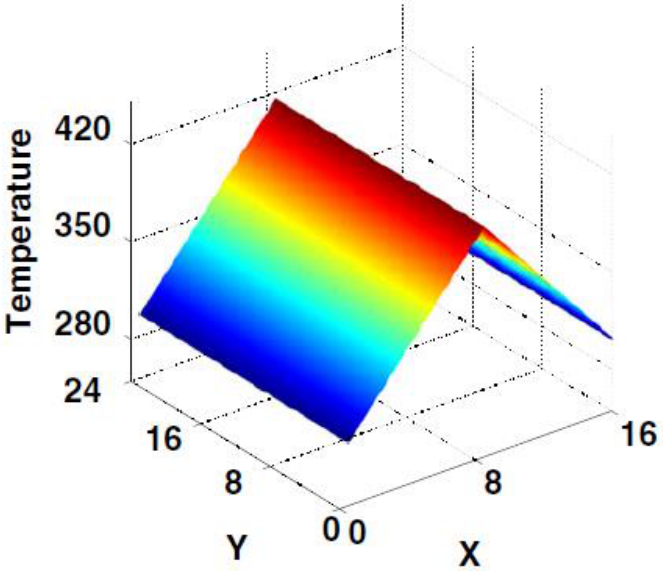
Figure 16. Temperature distribution applied to the sample in Figure 15 [111] (Reprinted with permission from [111]).